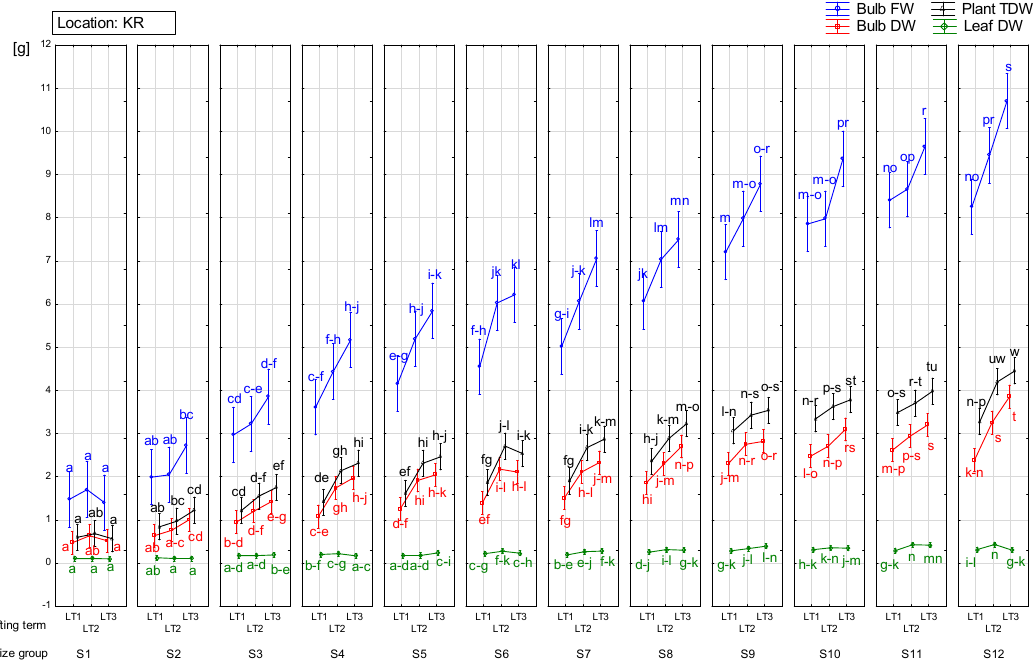
Figure 4. Effect of size group and lifting term on measured dry weight of bulb (DW) and fresh weight of bulb (FW) of organs parameters for Krakow (KR) location. Mean values within the same color with different letters are significantly different according to Duncan’s multiple range test at p ≤ 0.05. For treatments description, see 2.1.–2.4, Materials and Methods sections.